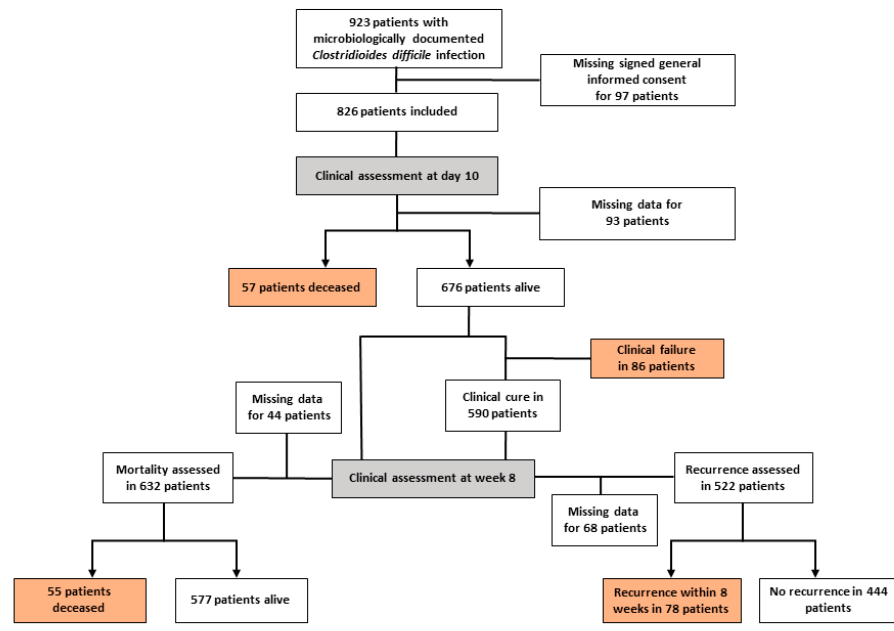
Figure 1. Figure 1. Flowchart.